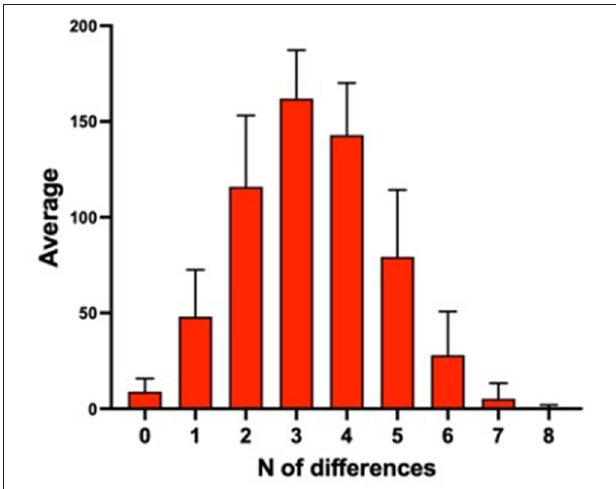
FIGURE 1 | Mean number of antigenic differences among 595 samples of the database.